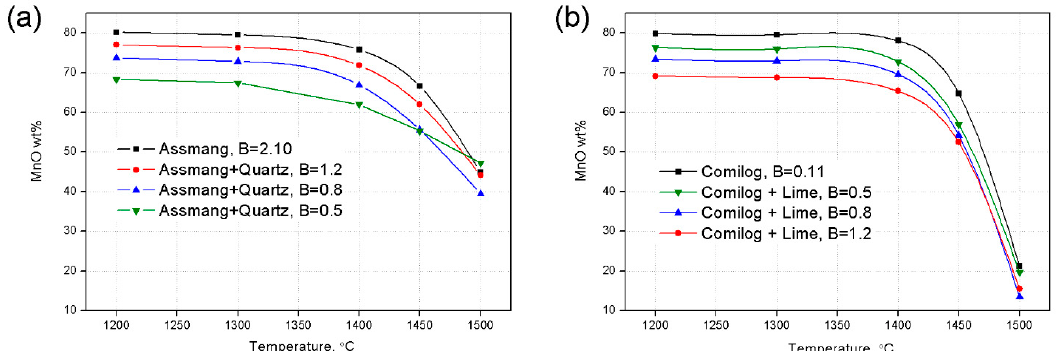
Figure 4. Calculated %MnO in the slag versus temperature from all experiments. ( a ) Assmang series; ( b ) Comilog series.